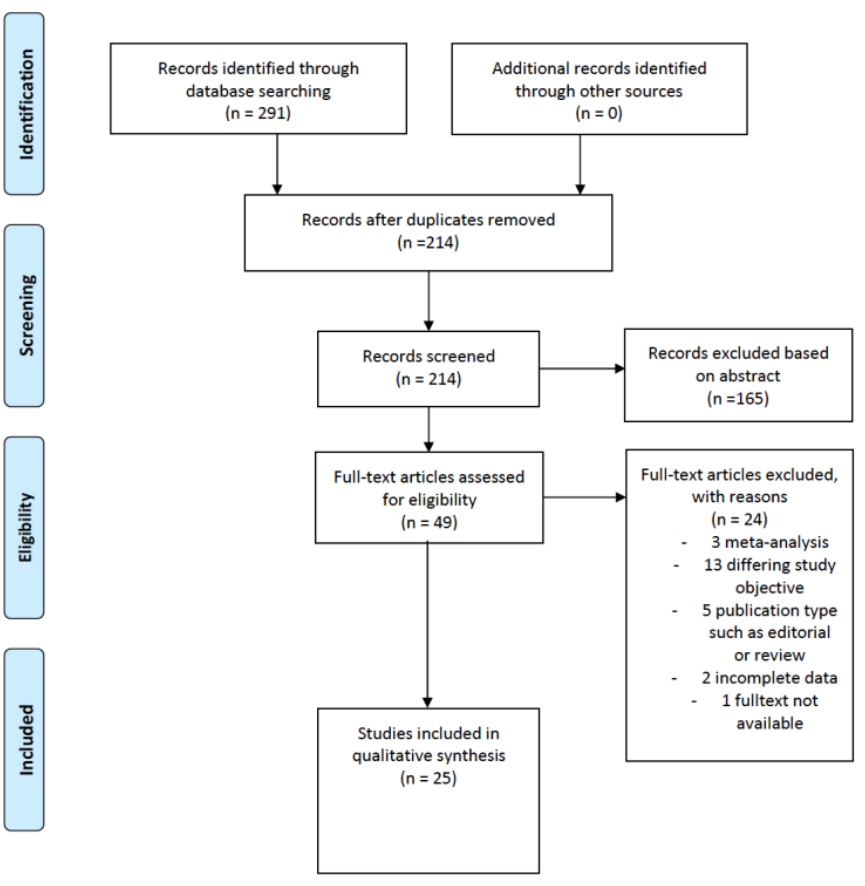
Figure 1. PRISMA flow chart of study identification.